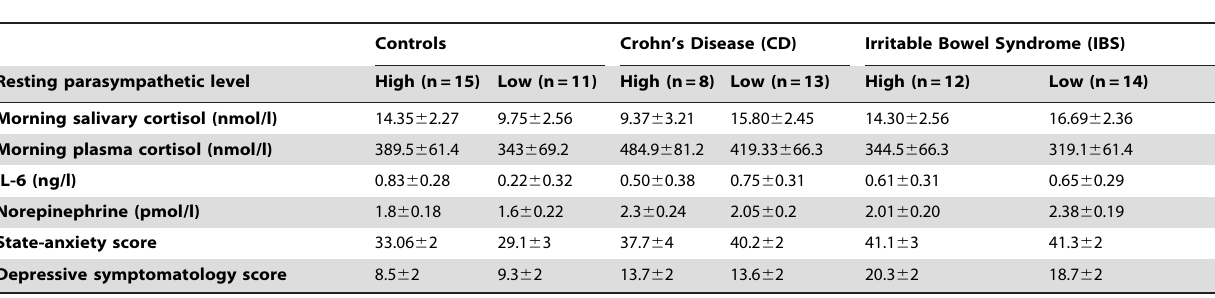
Table 3. Influence of the vagal tone on the plasma levels of the morning salivary and plasma cortisol, IL-6, norepinephrine concentrations, state-anxiety and depressive symptomatology scores in Controls, Crohn’s disease (CD) and Irritable Bowel syndrome (IBS) patients.